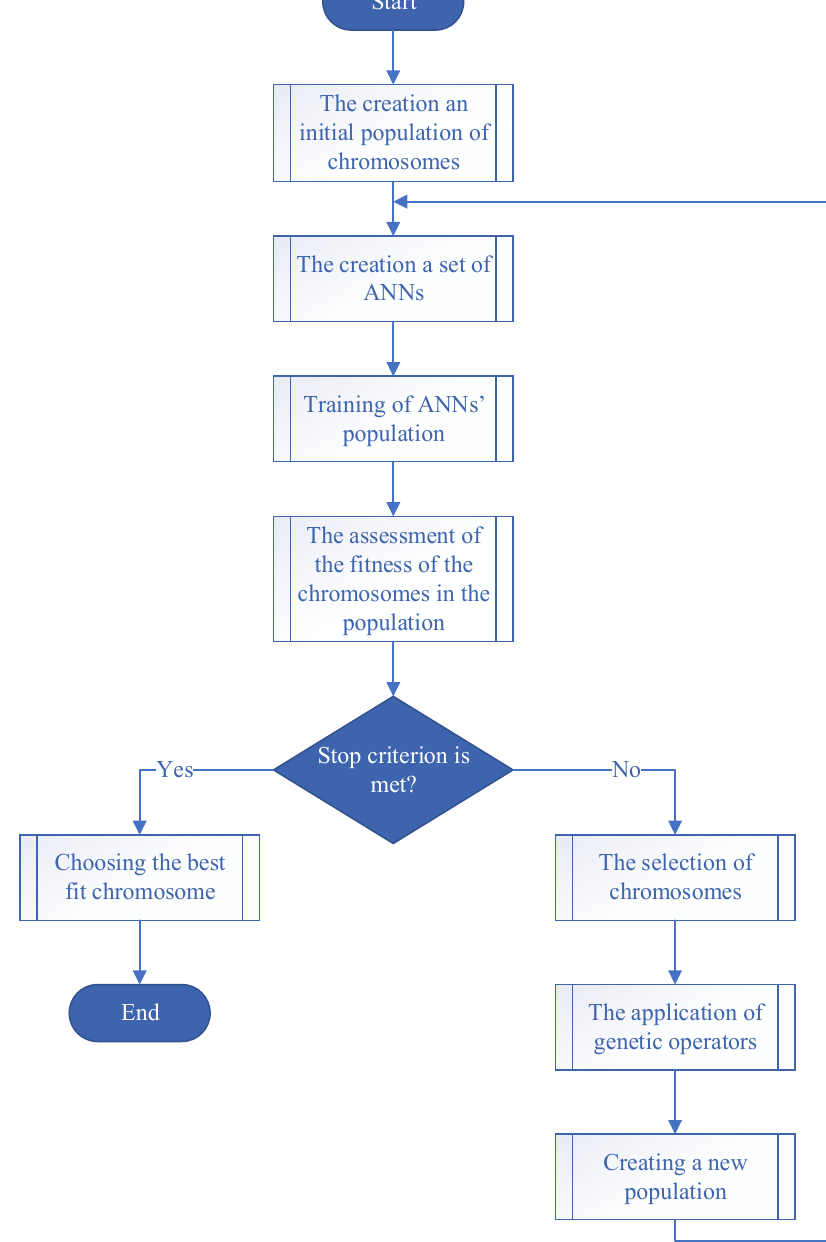
Figure 10. Block diagram of a genetic algorithm for determining the optimal structure of an artificial neural